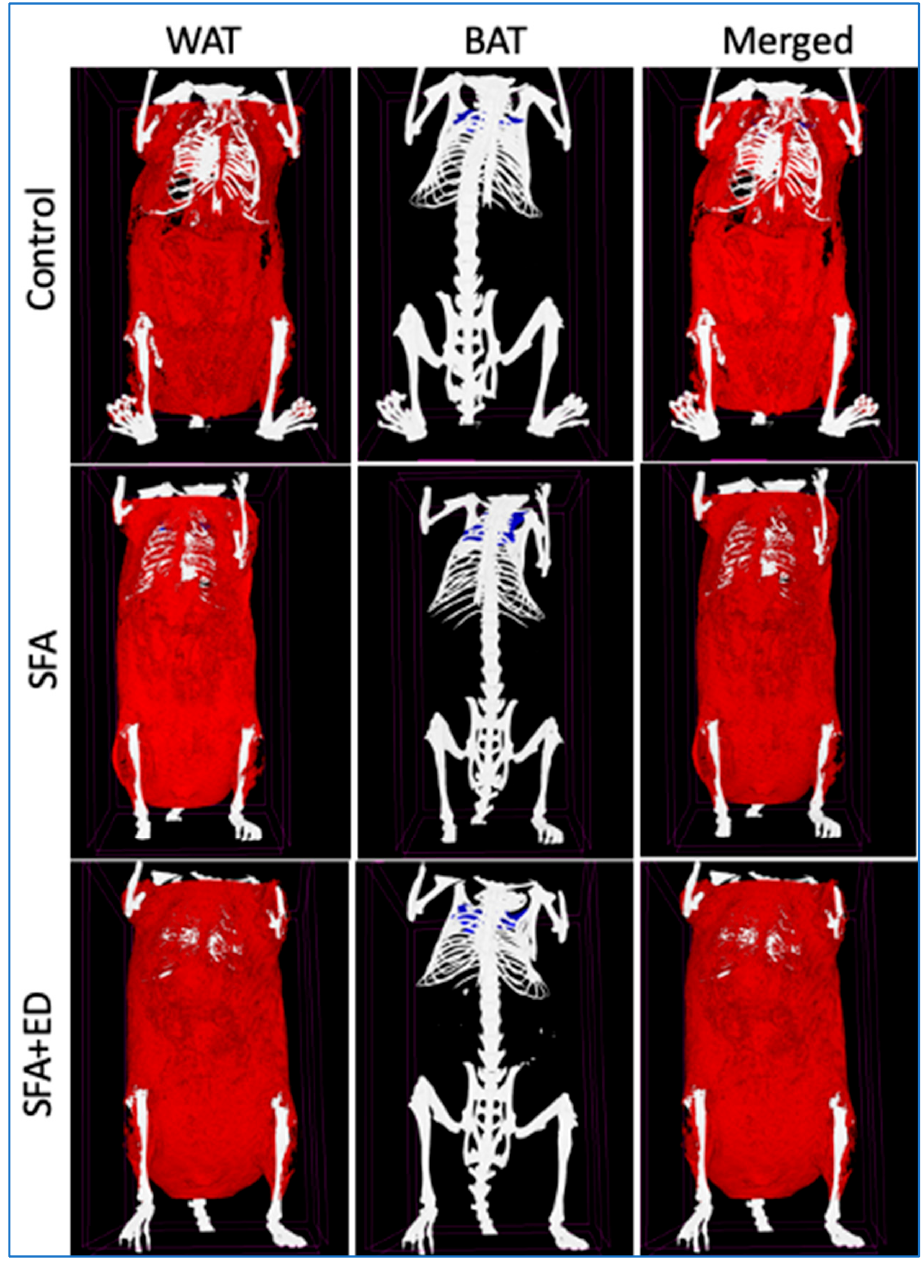
Figure 3. Representative Skyscan images of adipose tissue. Representative Skyscan x-ray microto- mography images for the mice received no liquid intervention (control), saturated fat enriched diet (SFA) or SFA with ED (SFA + ED) for 13 weeks are presented. White adipose tissue (WAT) is shown in red while brown adipose tissue (BAT) is shown in blue.